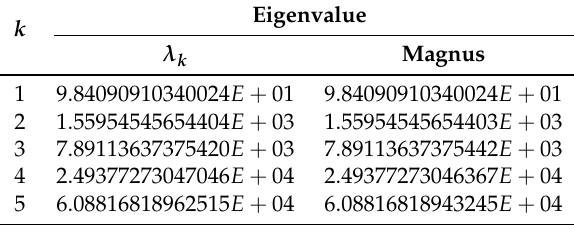
Table 4. The first five eigenvalues for y ( 4 ) + y = λ y , y ( 0 ) = y (cid:48)(cid:48) ( 0 ) = y ( 1 ) = y (cid:48)(cid:48) ( 1 ) = 0.